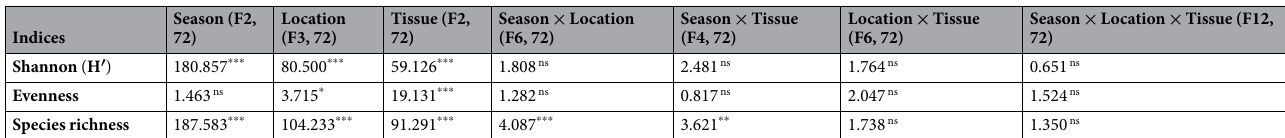
Table 3. Summary of MANOVA of different diversity indices. *** Significant at p ≤ 0. 001, ** Significant at